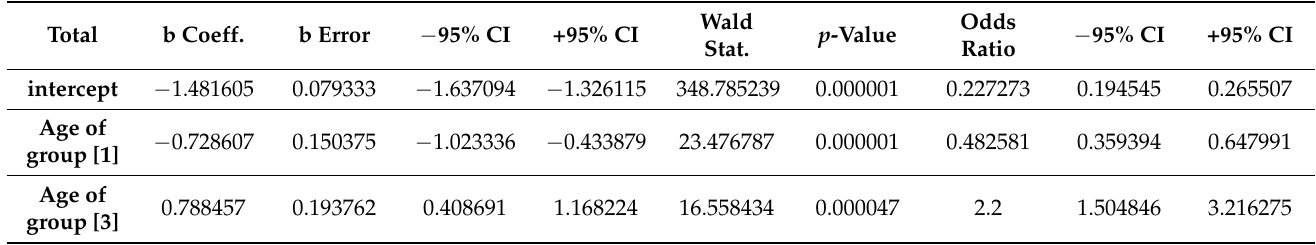
Table 12. Logistic regression model for total fear symptoms and three age groups.